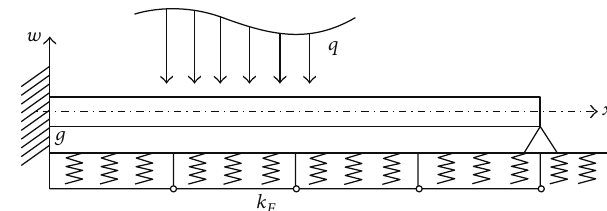
Figure 1: Beam resting on elastic foundation.